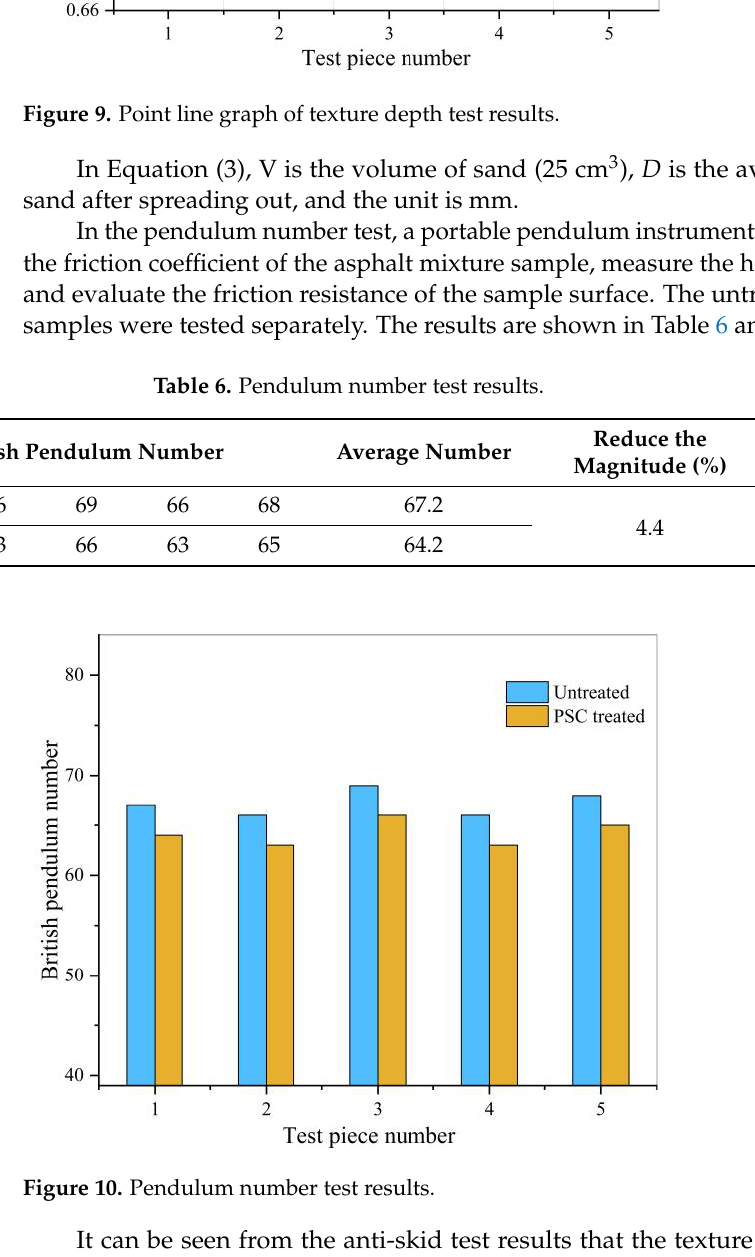
Figure 9. Point line graph of texture depth test results.